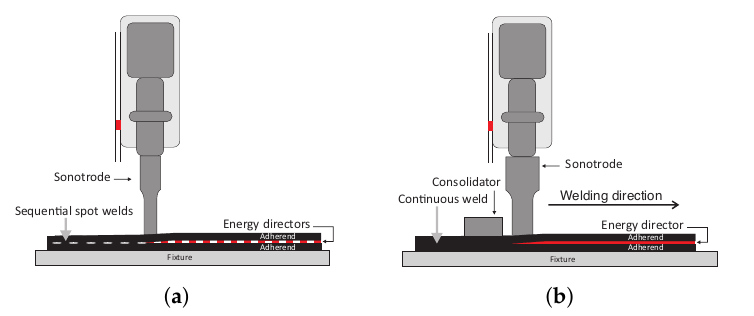
Figure 1. Schematics of static ( a ) and continuous ( b ) ultrasonic welding processes for thermoplastic